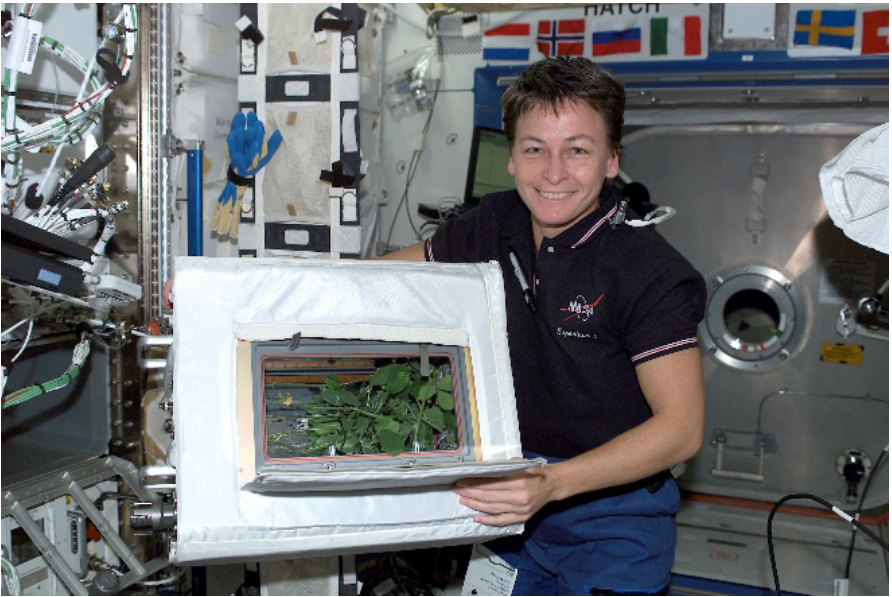
Figure 2. Flight engineer Peggy Whitson was pleased to show soybean plants growing in the Advanced Astroculture TM (ADVASC) Experiment hardware on the ISS on July 10, 2002. The hardware provided precise control of light, temperature, fluid nutrient delivery, relative humidity, carbon dioxide (CO ) and ethylene concentrations. An agricultural seed company grew the soybeans in the ADVASC hardware to determine 2 if soybean plants could go from seed to seed in a microgravity environment. Secondary objectives included determination of the chemical composition of the seeds grown in space and whether microgravity had an impact on the plant growth cycle. Image catalogued by Marshall Space Flight Center of the United States National Aeronautics and Space Administration (NASA) Photo ID: MSFC-75-SA-4105-2C. Image credit: NASA https://mix.msfc.nasa.gov/abstracts.php?p=2393